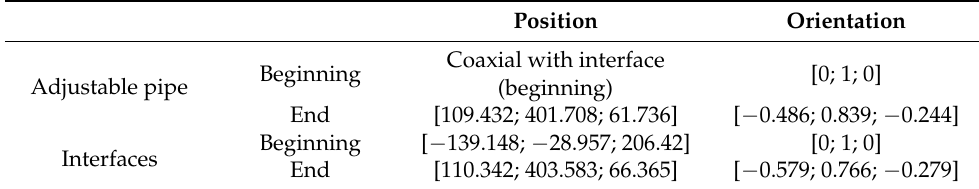
Figure 11. Initial state for virtual assembly of adjustable pipe: ( a ) adjustable pipe; ( b ) measurement and reconstruction of pipe following production process; ( c ) pair of interfaces; and ( d ) existing deviations of the end. Table 1. Initial poses of adjustable pipe and pair of